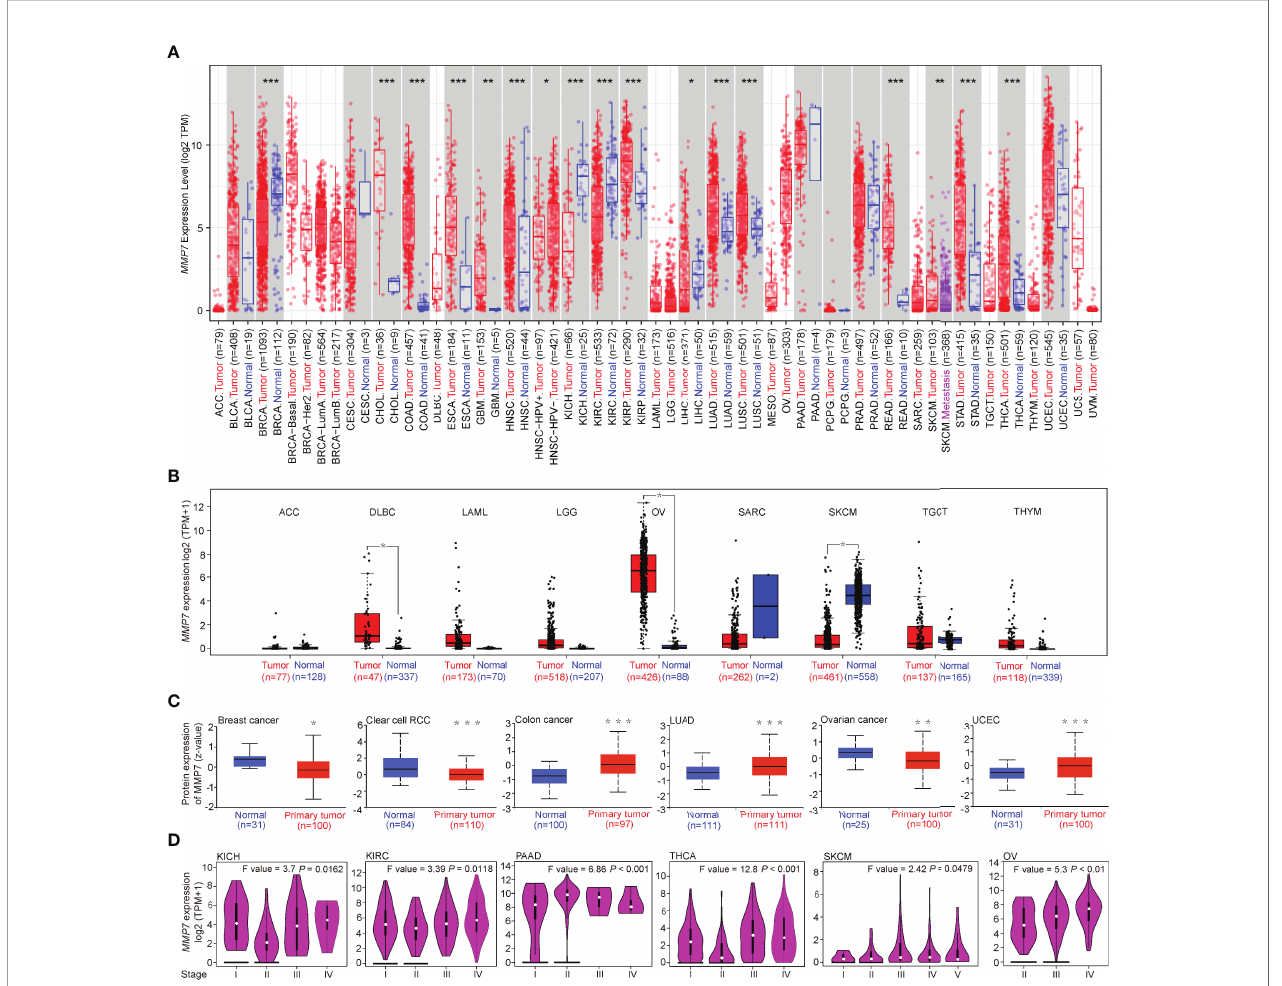
FIGURE 1 | Differential expression of MMP7 across TCGA cancer types and the pathological stages. (A) Matrix metallopeptidase ( MMP7 ) expression level in various cancers (red) vs . normal controls (blue) using TIMER2. (B) The expression difference of MMP7 between the tumor (red) and normal tissues (blue) in adenoid cystic carcinoma, diffuse large B-cell lymphoma, acute myeloid leukemia, low-grade glioma, ovarian cancer, sarcoma, skin cutaneous melanoma, testicular germ cell tumor, and thymoma (ACC, DLBC, LAML, LGG, OV, SARC, SKCM, TGCT, and THYM, respectively) based on The Cancer Genome Atlas (TCGA) and GTEx database using GEPIA2. (C) The protein expression level of MMP7 in tumors tissues (red) compared with the control tissues (blue) of breast cancer, clear cell renal cell carcinoma (RCC), colon cancer, lung adenocarcinoma (LUAD), OV, and uterine corpus endometrial carcinoma (UCEC) was determined based on the CPTAC database by UALCAN. (D) Correlation between differential expression of MMP7 and the pathological stages of kidney chromophobe (KICH), kidney renal clear cell carcinoma (KIRC), pancreatic adenocarcinoma (PAAD), thyroid carcinoma (THCA), KIRC, SKCM, and OV (GEPIA2). * P < 0.05; ** P < 0.01; *** P <